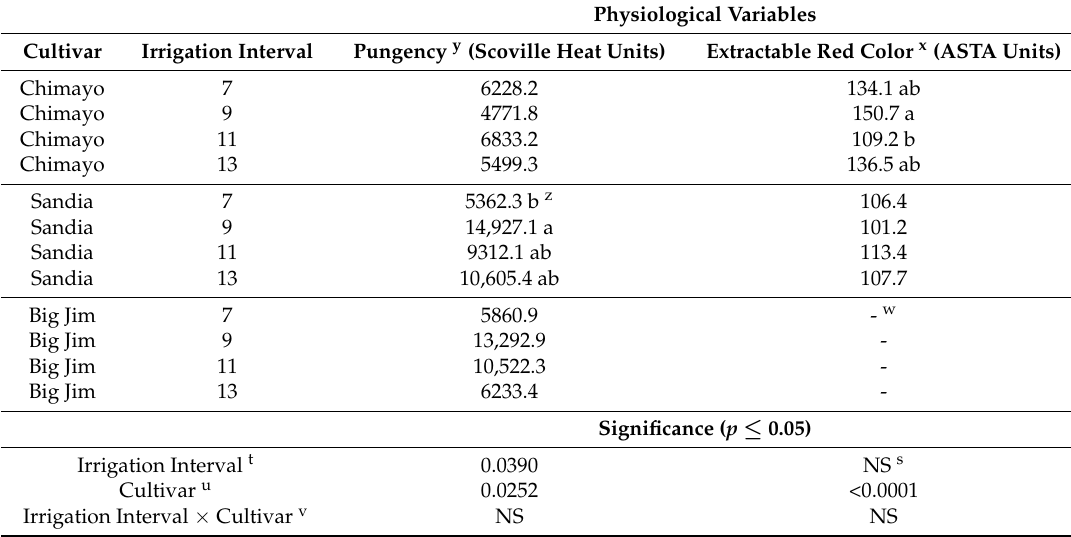
Table 5. Main effects and interactions of three cultivars and four irrigation intervals on physiological fruit characteristics, 2011.